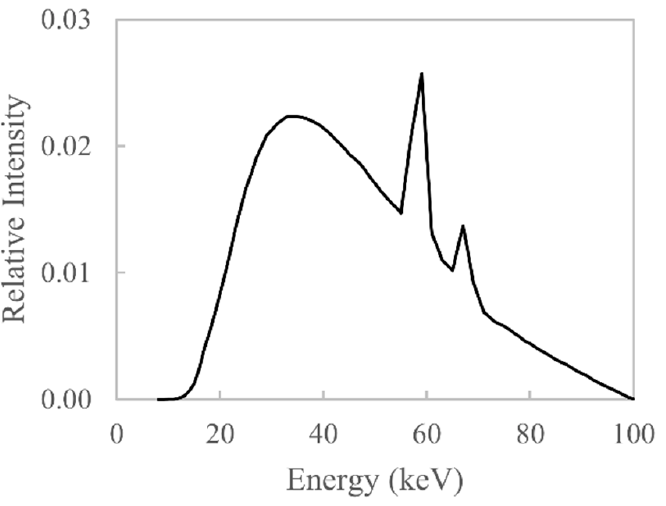
Figure 1. A simulated polychromatic X-ray spectrum emitted by a tungsten reflection target X-ray source, obtained using the model in [7].